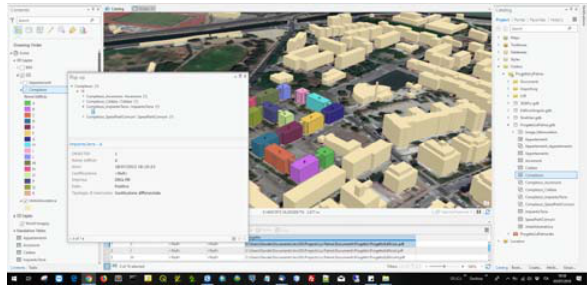
Figure 10. Archiving the buildings’ and apartments’ documentation in